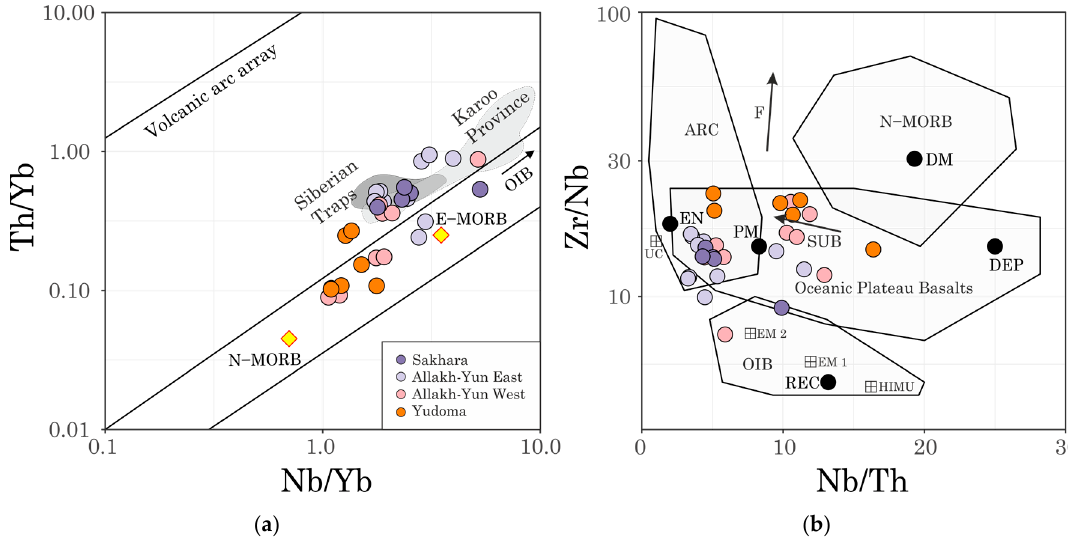
Figure 10. ( a ) Th/Yb–Nb/Yb plot [34,35]. The composition of the Siberian Traps (dark gray field) is taken from [36], while the composition of the Karoo Province is taken from [37]. ( b ) Zr/Nb–Nb/Th plot [38]. Abbreviations: UC—upper continental crust; PM—primitive mantle; DM—shallow depleted mantle; HIMU—high mu (U/Pb) source; EM 1 and EM 2—enriched mantle sources; ARC—arc-related basalts; N-MORB—normal mid ocean ridge basalt; OIB—oceanic island basalt; DEP—deep